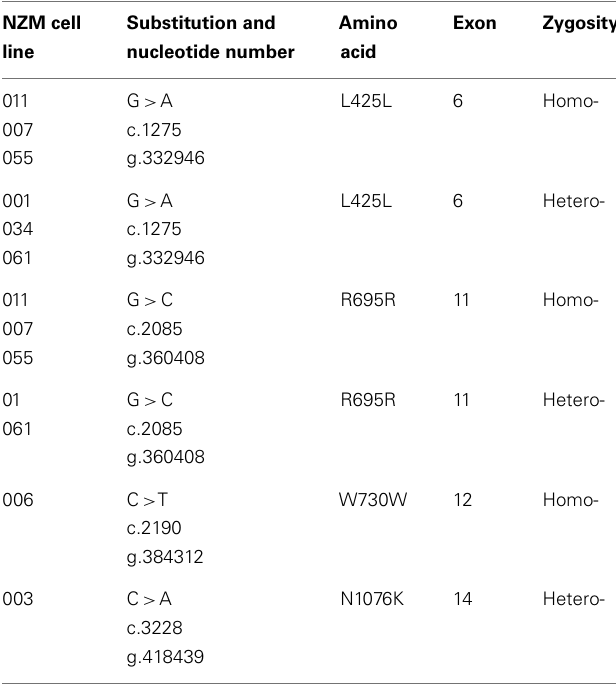
Table 5 | GRIN2A SNPs in tumor-derived cell lines